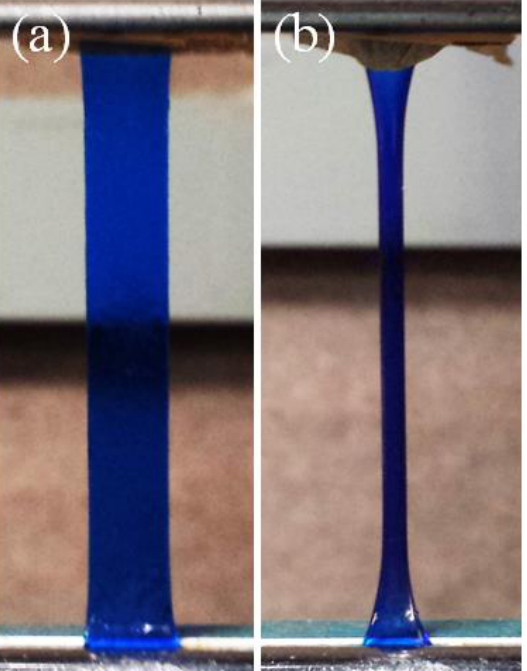
Figure 3. AMPS(1,2,2,9)/AAm(2,0.1,0.01,97) DN hydrogel. ( a ): after being extended to λ = 2 ; ( b ): after being dried overnight in the extended form.